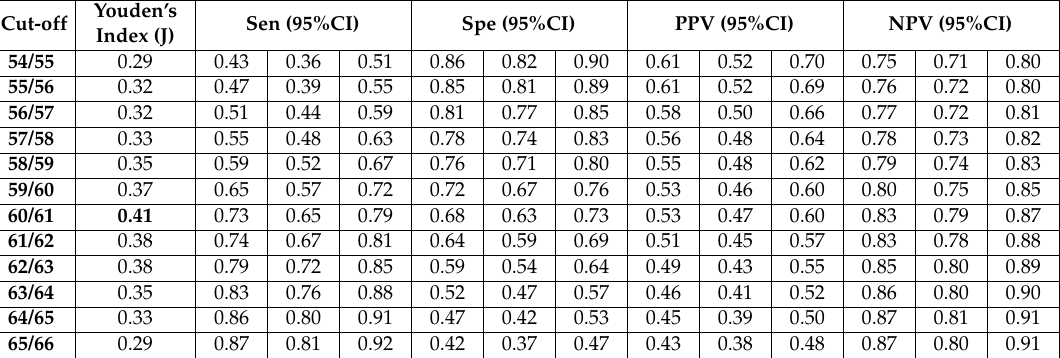
Figure 2. Receiver Operating Characteristic curve for the Quick Mild Cognitive Impairment (Q mci -J) screen to detect those with suspected Mild cognitive impairment (MCI) or dementia ( left ) and those with suspected dementia ( right ). Table 2. Sensitivity (Sen), Specificity (Spe), Positive Predictive Value (PPV), Negative Predictive Value (NPV, with 95% confidence intervals, for different Quick Mild Cognitive Impairment (Q mci -J) screen cut-off scores for suspected cognitive impairment (suspected MCI and dementia), without adjustment for age or education, compared with normal controls.